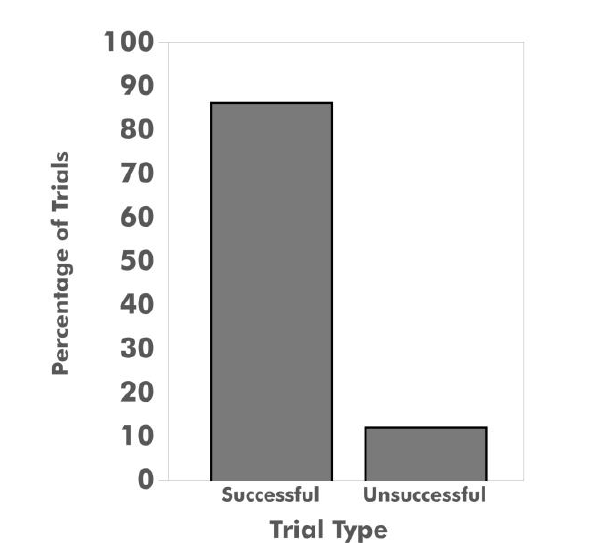
Figure 1. Percentage of trials during which mothers successfully or unsuccessfully called their respective calves.